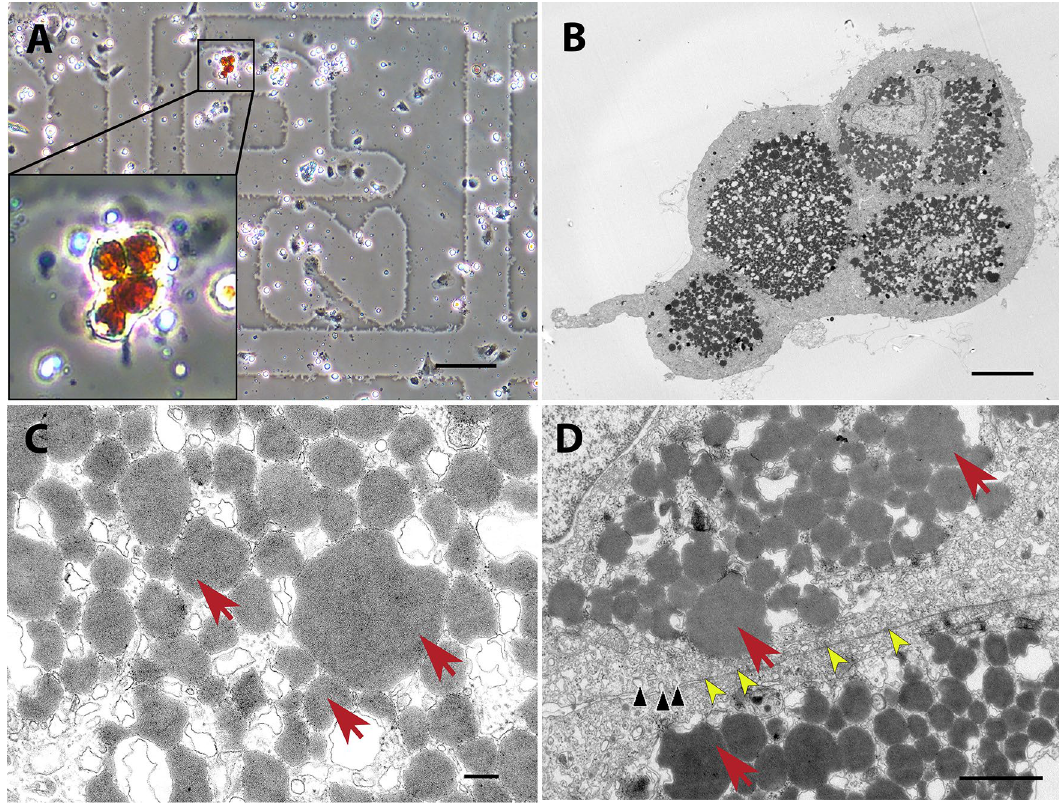
Figure 4. CLEM of a type 2 erythrophore from red spot. ( A ) Four isolated erythrophores on a MatTek dish, observed with phase-contrast microscopy. ( B – D ) Ultrastructure of the same cells, observed with TEM. Erythrosomes (red arrows). ( D ) Numerous caveolae near the cell membrane (black arrowheads) and cell junctions (yellow arrowheads). Scale bars: 100 μm ( A ); 6 μm ( B ); 200 nm ( C ); 1 µm ( D